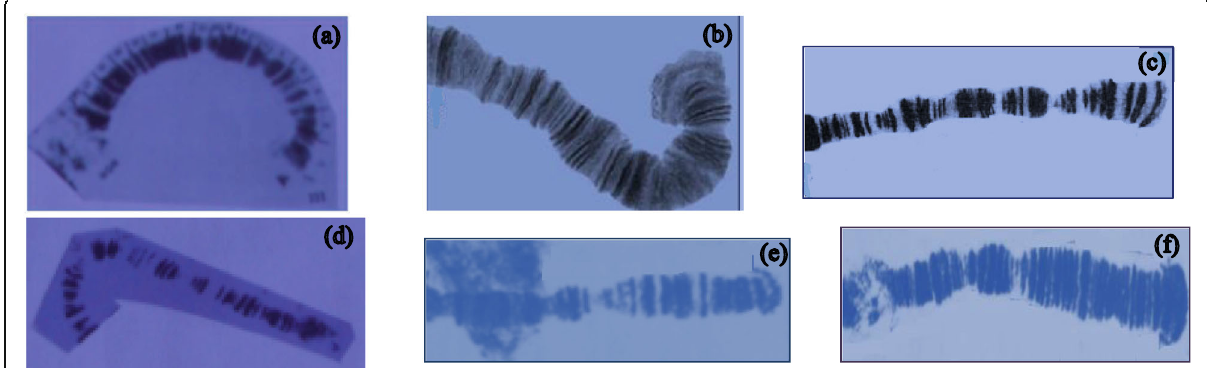
Fig. 2 Arm A of the polytene chromosomes of six species of Chironomus. a C. javanus. b C. dorsalis. c C. riparius. d C. matures. e C. maddeni. f